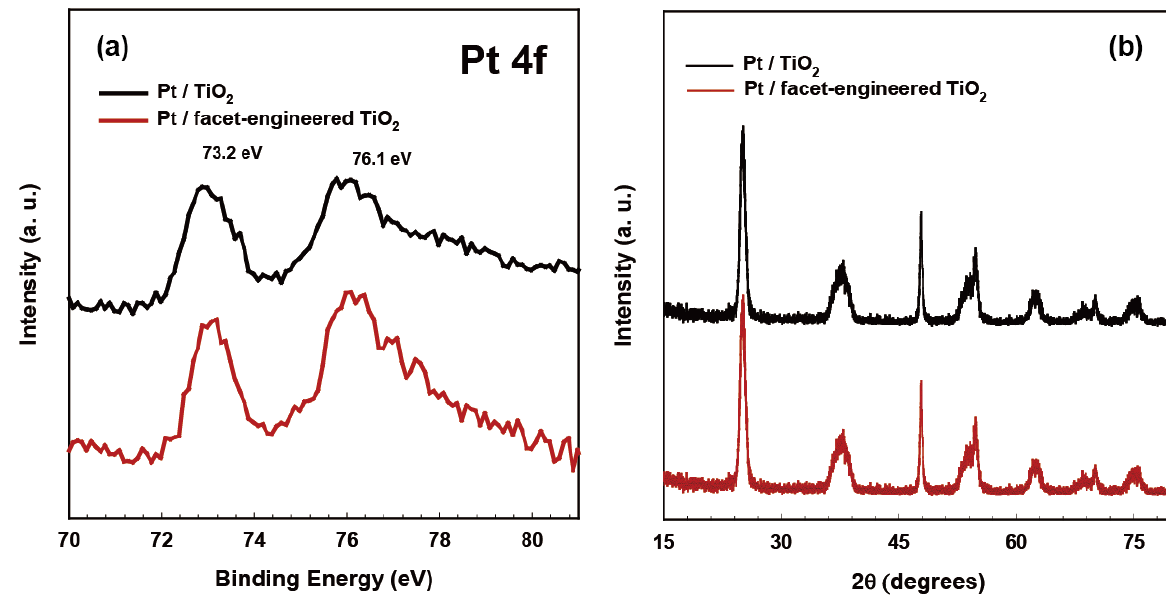
Figure 2. ( a ) XPS spectra and ( b ) XRD pattern of Pt 4f of Pt/TiO 2 and Pt/facet-engineered TiO 2 .